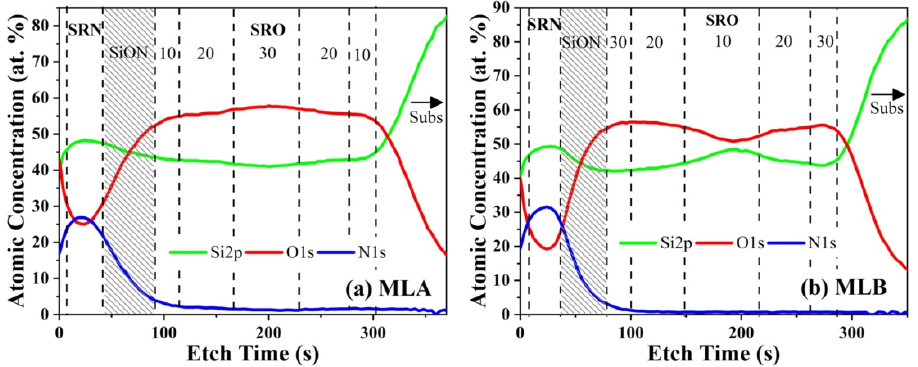
Figure 1. XPS depth profile for Si2p, O1s, N1s signal for ( a ) MLA and ( b ) MLB after thermal annealing.